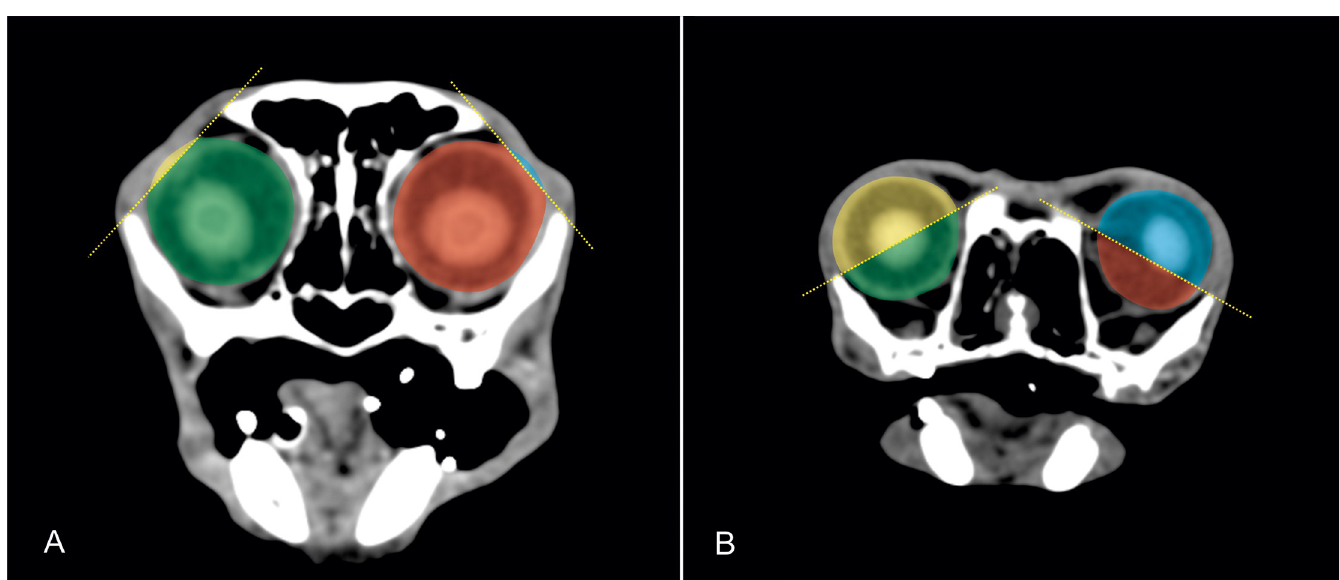
Fig 3. Measurement of the extra-orbital parts of the eye globes. Two-dimensional CT images in a transversal plane of a Domestic shorthair cat (A) and a Persian cat (B) demonstrating the segmentation of the intra-orbital and extra-orbital parts of the bulbi oculi: yellow = extra-orbital part of the right eye; green = intra-orbital part of the right eye; red = intra-orbital part of the left eye; blue = extra-orbital part of the left eye.